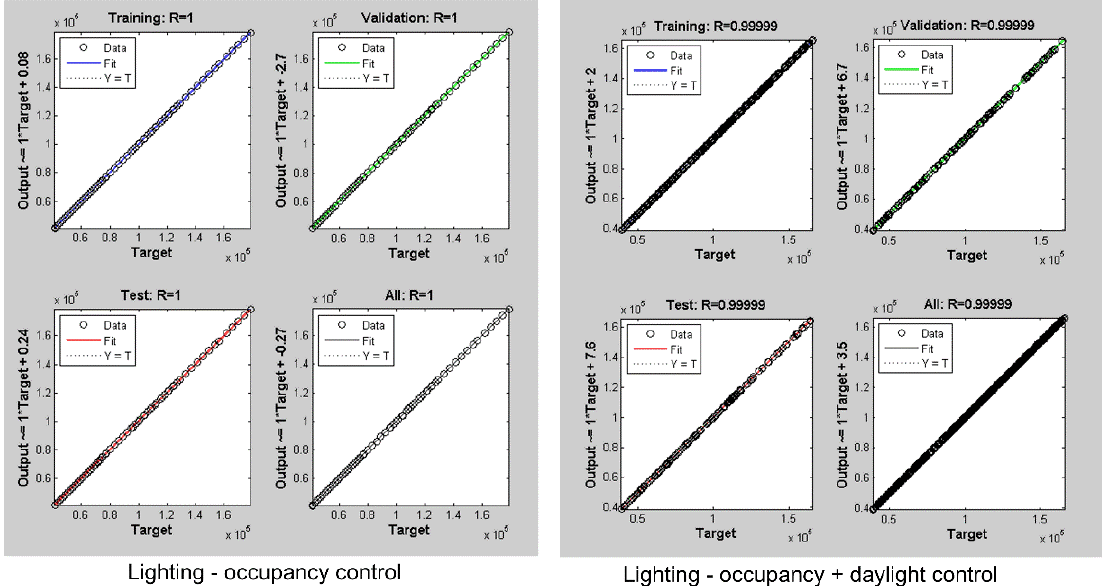
Figure 8. Neural network training and testing results for lighting energy